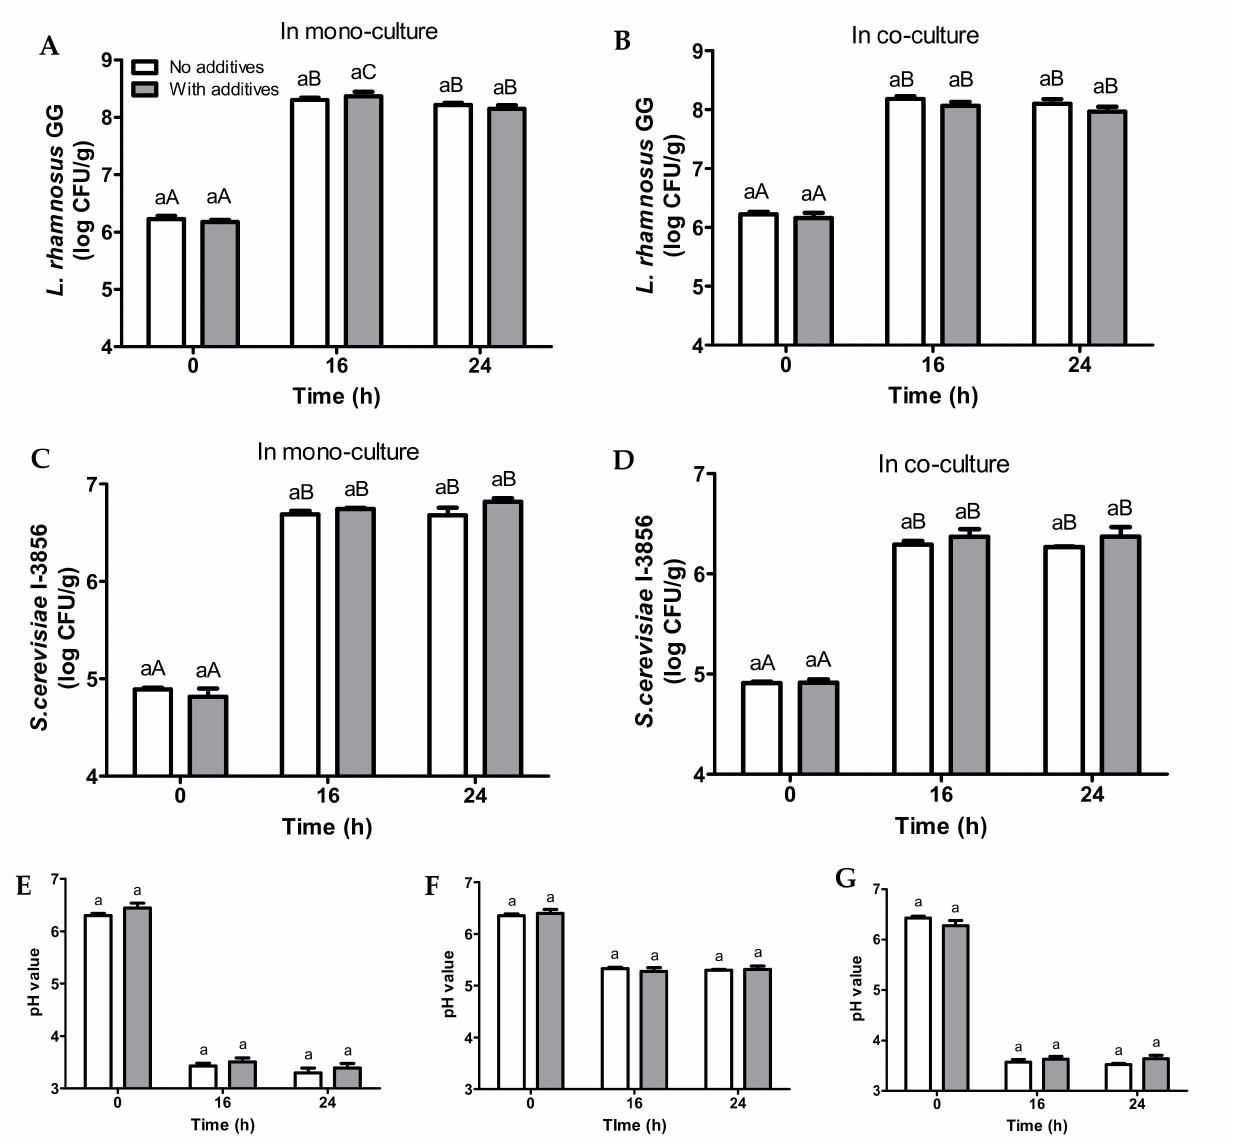
Figure 4. Changes in viable L. rhamnosus GG cell counts in mono-culture ( A ) and co-culture ( B ), S. cerevisiae CNCM I-3856 cell counts in monoculture ( C ) and co-culture ( D ). Changes in pH during 37 ◦ C incubation for bread slurries inoculated with L. rhamnosus GG only ( E ), S. cerevisiae CNCM I-3856 only ( F ), and L. rhamnosus GG + S. cerevisiae CNCM I-3856 ( G ) during 37 ◦ C